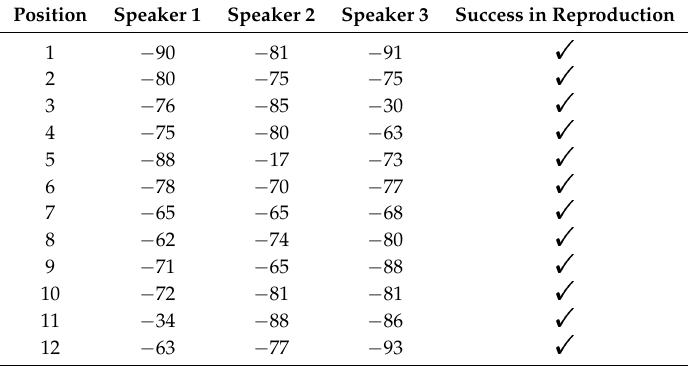
Table 3. Detecting position of Sufferer, based on the Bluetooth ID device RSSI, as measured by the smart speakers. The measures correspond to the second test set (user =